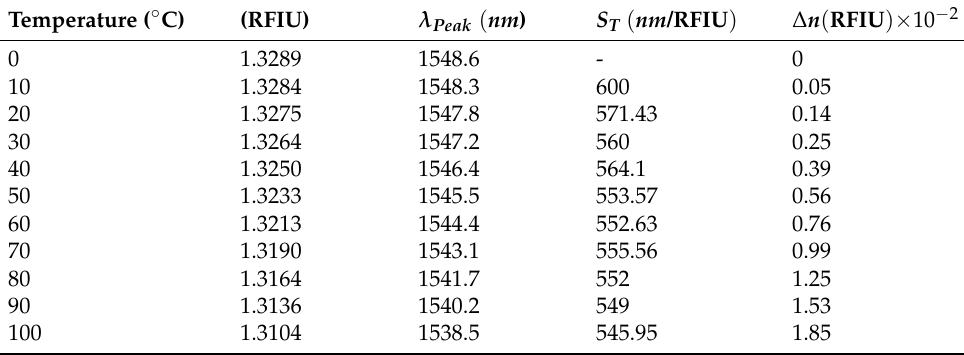
Table 3. Variation of the RFIU, λ peak and S T as a Function of